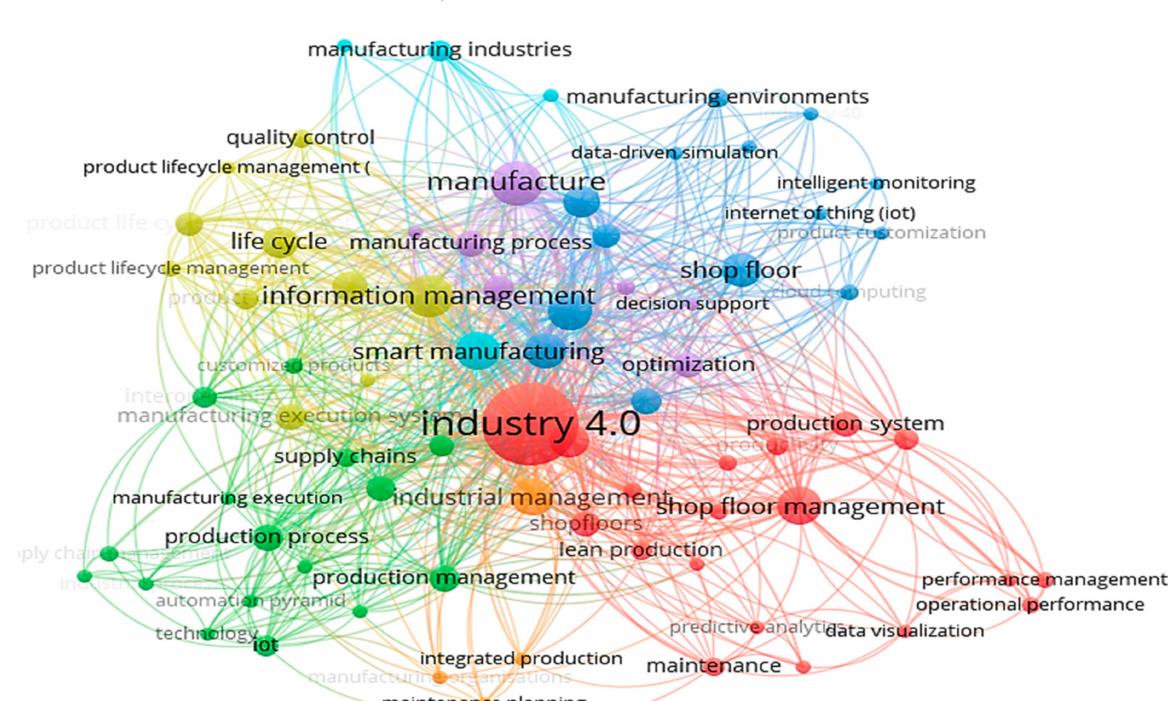
Figure 2. Scholarly works over time.